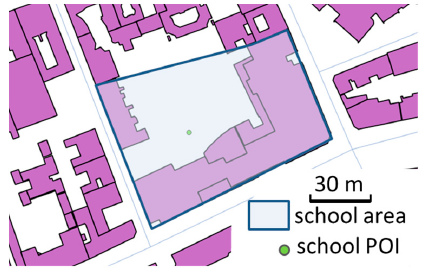
Figure 7. A school area, buildings, and a school POI: schools can be composed of several buildings and school yards, so the POI might be located outside a building (©OpenStreetMap contributors).